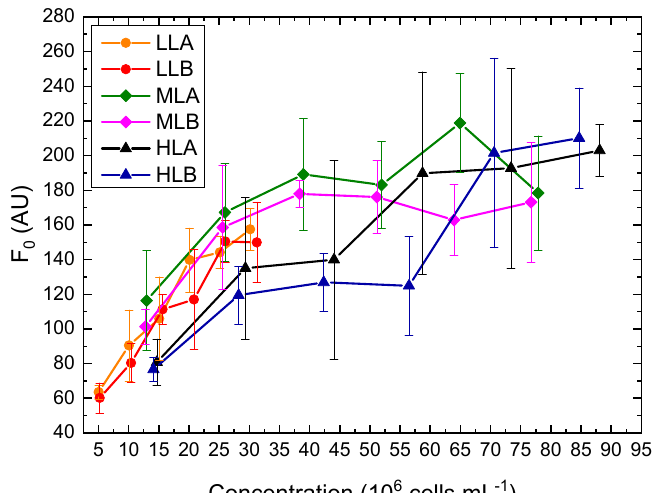
Figure 6. Trend of 𝐹 (cid:3049) /𝐹 (cid:3040) (e.g., maximum quantum efficiency of PSII), over time for the six batch experiments.